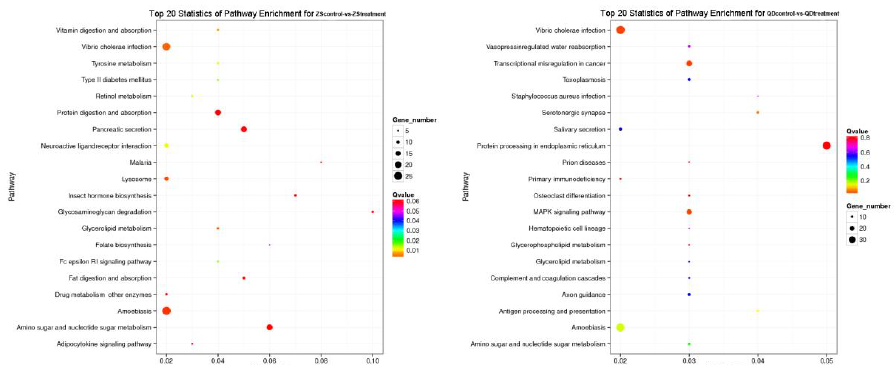
Figure 7. Top 20 pathway enrichment statistics for each population exposed to the same thermal stress (ZS control : Zhoushan population at 20 °C; ZS treatment : Zhoushan population at 28 °C; QD control : Qingdao stress (ZS control : Zhoushan population at 20 ◦ C; ZS treatment : Zhoushan population at 28 ◦ C; QD control : population at 20 °C; QD treatment : Qingdao population at 28 °C). Qingdao population at 20 ◦ C; QD treatment : Qingdao population at 28 ◦ C).